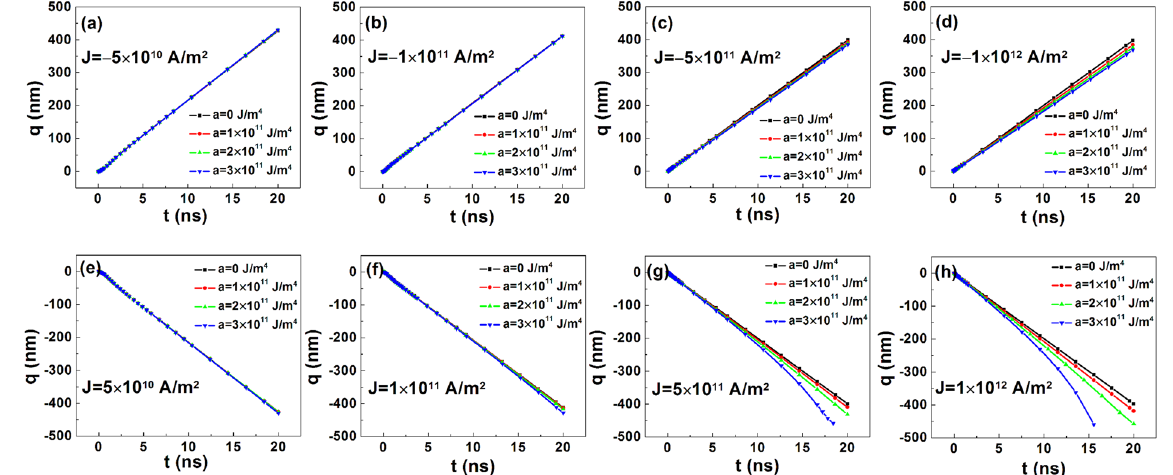
Figure 2. Change in time ( t ) of the central position of the domain wall ( q ) in the nanotracks with magnetic anisotropy gradient under current with different densities. The four figures in the first row show the q − t curves under negative current with the current density ( J ) of ( a ) − 5 × 10 10 A/m 2 , ( b ) − 1 × 10 11 A/m 2 , ( c ) − 5 × 10 11 A/ m 2 , and ( d ) − 1 × 10 12 A/m 2 respectively. The four figures in the second row show the q - t curves under positive current with the J of ( e ) 5 × 10 10 A/m 2 , ( f ) 1 × 10 11 A/m 2 , ( g ) 5 × 10 11 A/m 2 , and ( h ) 1 × 10 12 A/m 2 respectively. The slopes for the anisotropy constant ( a ) are 0 (marked in black), 1 × 10 11 (marked in red), 2 × 10 11 (marked in green), and 3 × 10 11 J/m 4 (marked in blue).